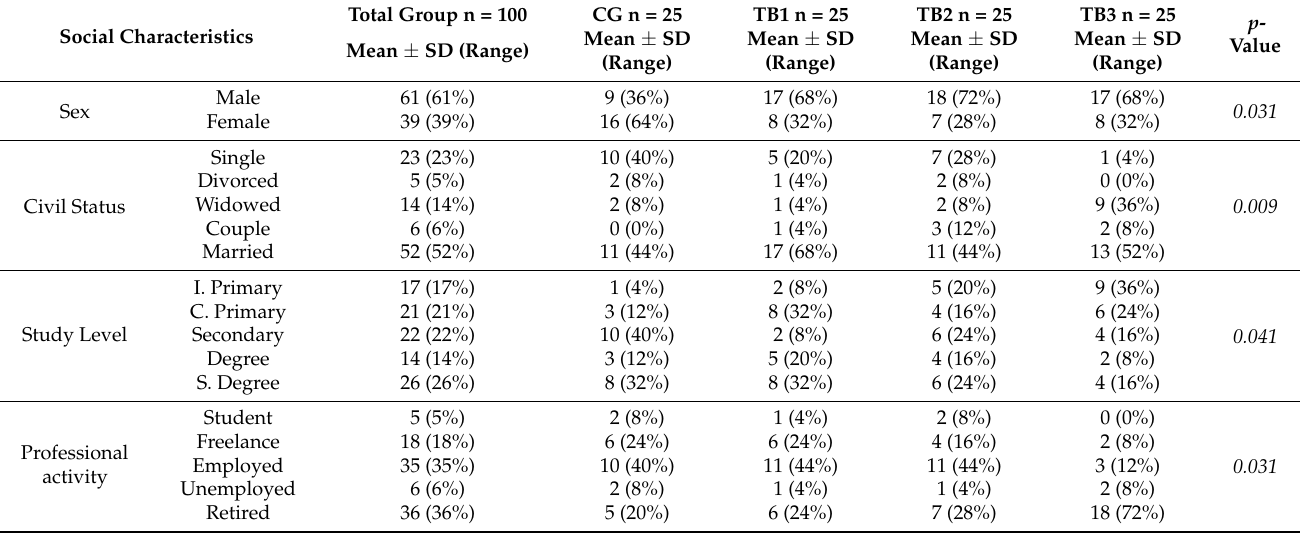
Table 4. Demographic and descriptive data of the sample population according to classification of tailor’s